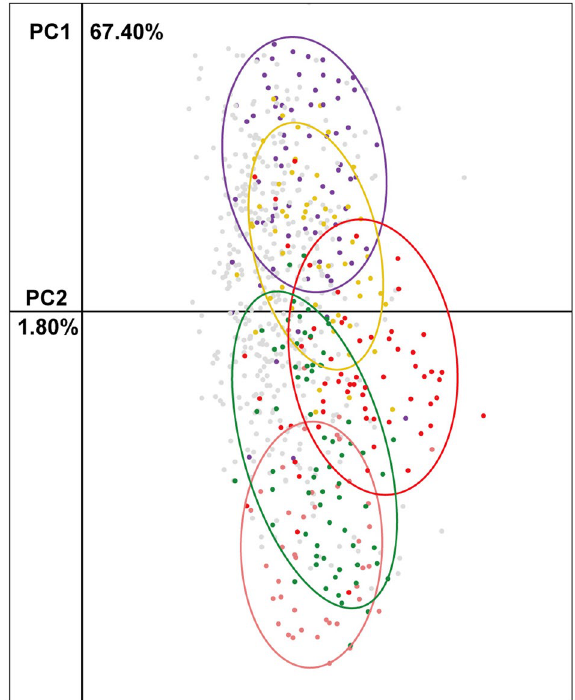
Figure 3. Principal coordinates analyses (PCAs) based on the matrix of Nei ’s unbiased genetic distance among 901 sampled individuals.